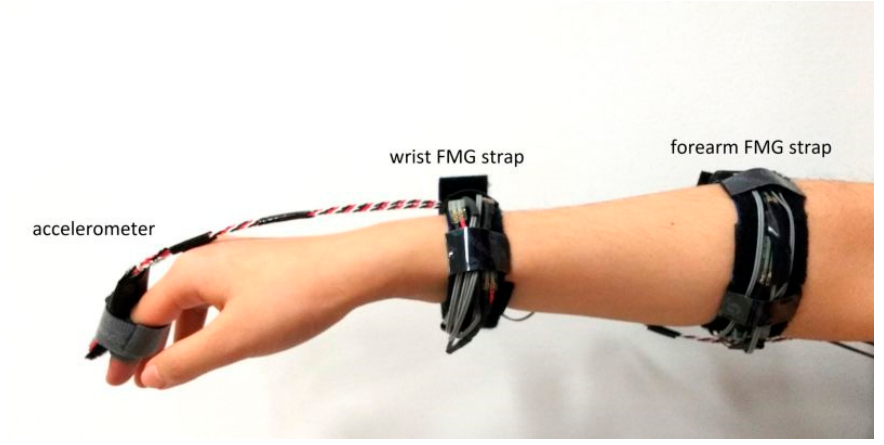
Figure 3. Sensor placement.